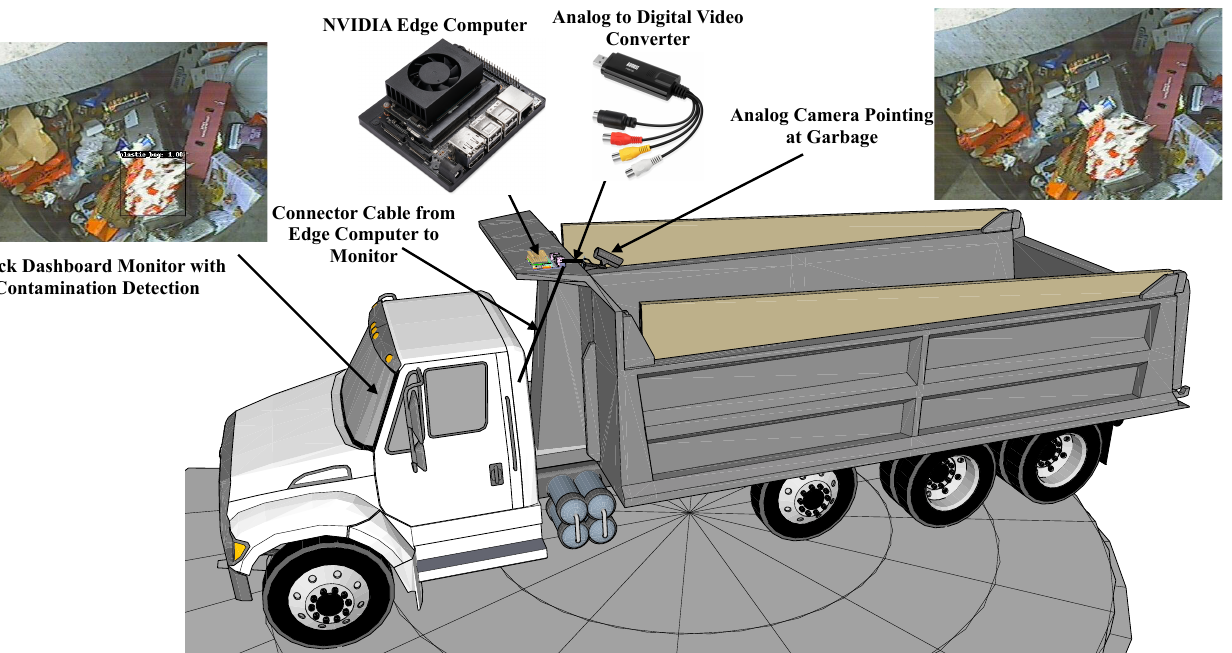
Figure 2. Conceptualization illustration of the proposed automated plastic-bag contamination detec-